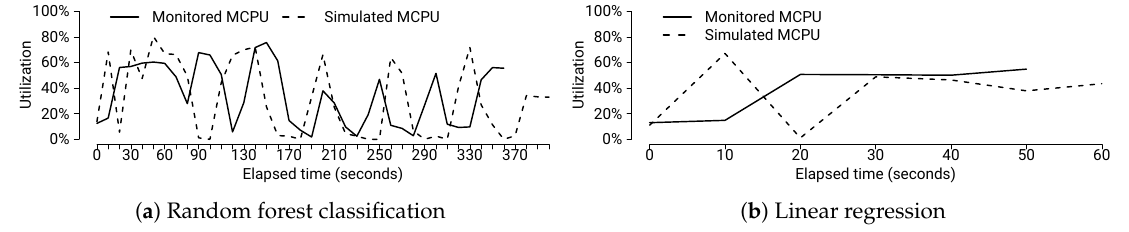
Figure 10. Mean CPU utilization of 16 worker nodes (huge data